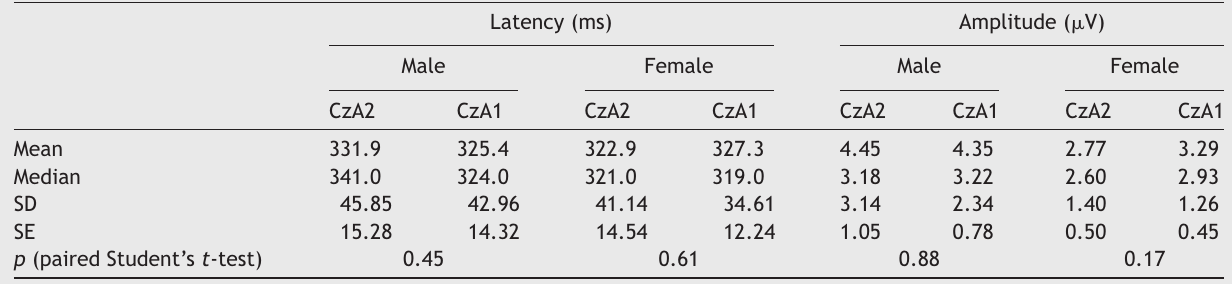
Table 1 Descriptive analysis of amplitude ( (cid:2) V) and latency (ms) of P300 according to